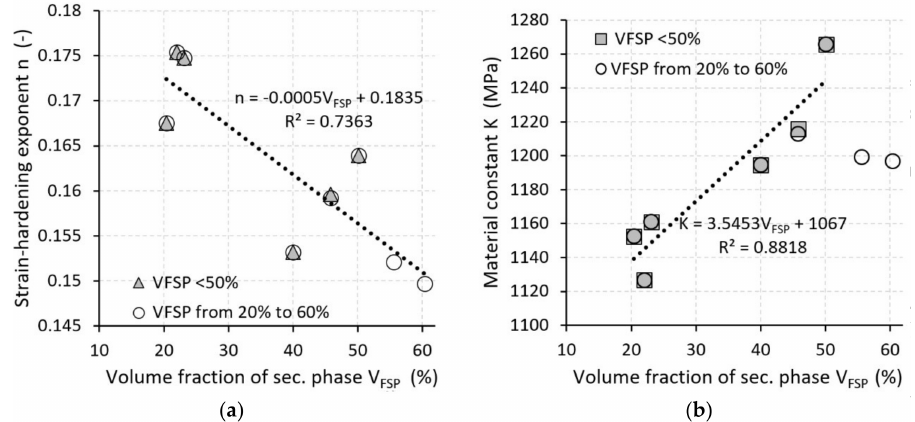
Figure 13. The dependence of the material parameters on the volume fractions of secondary phases: ( a ) the strain-hardening exponent n; ( b ) the material constant K.